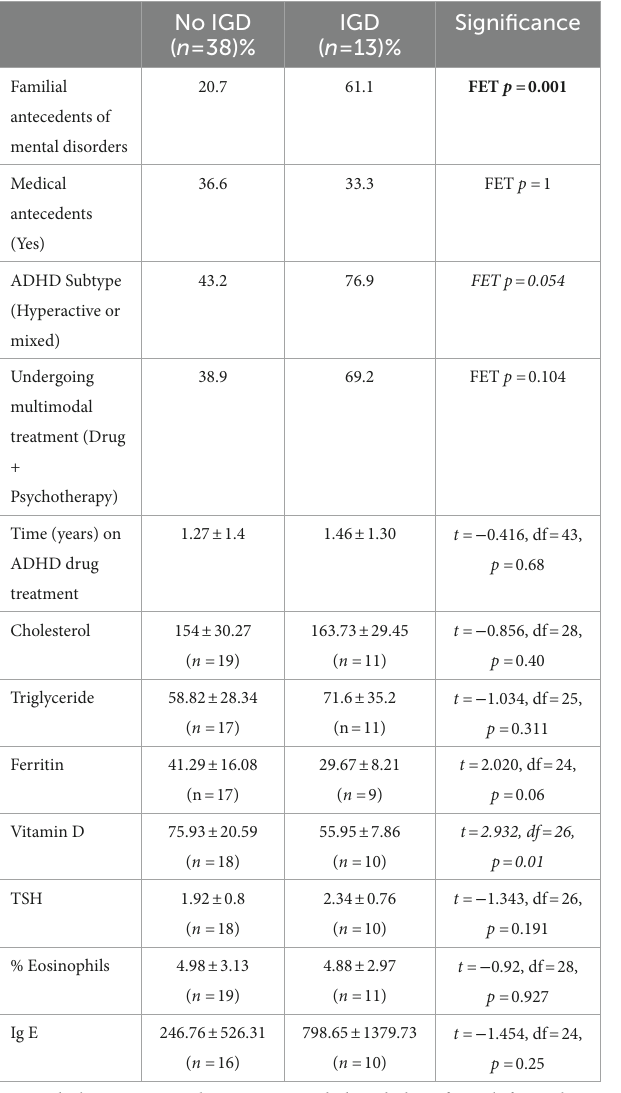
TABLE 2 Medical and ADHD antecedents, and blood analyses. TABLE 3 Neuropsychological